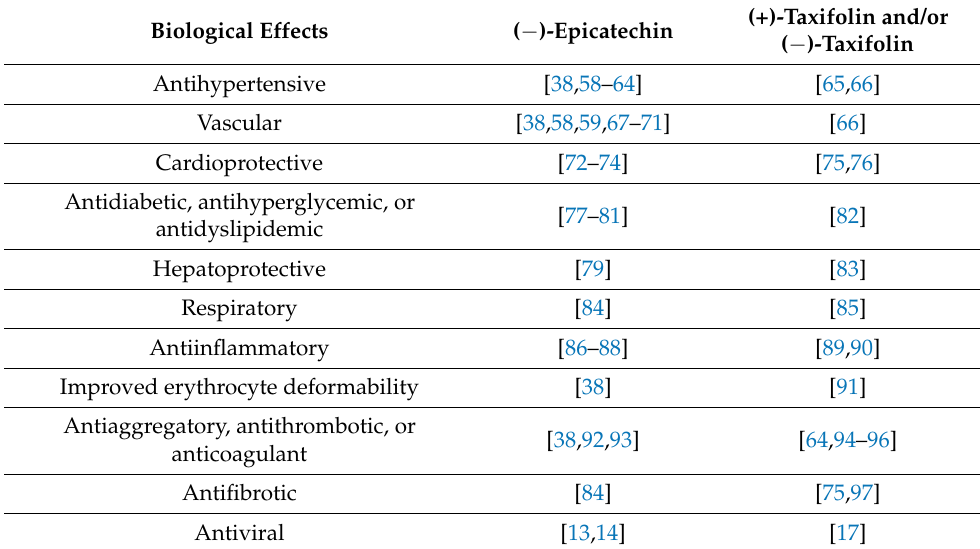
Table 1. Examples of the biological effects of ( − )-epicatechin as well as (+)-taxifolin and/or ( − )- taxifolin that were found in the experimental models and that may be relevant for the treatment of hypertension and viral